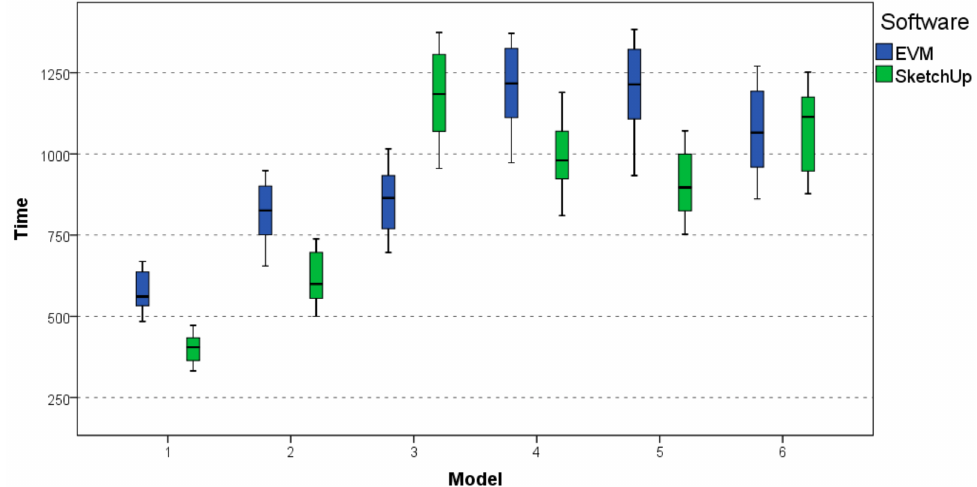
Figure 8. Boxplot for each modeling task using EVM and Trimble SketchUp.